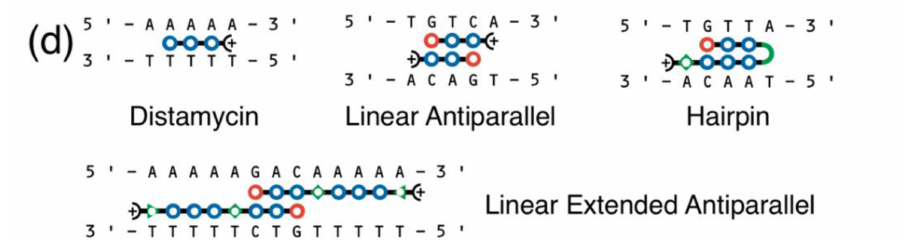
Figure 1. Schematics of pyrrole-imidazole polyamides and DNA binding. ( a ) Structure of distamycin A. ( b ) Illustrative model of hydrogen-bonding interactions between pyrrole-imidazole polyamides (PIPs) and the DNA minor groove; circles with dots represent lone pairs of purines and pyrimidines; circles containing an H represent the additional hydrogen on G; putative hydrogen bonds are indicated with dotted lines. Reprinted with permission from [1], © 2001 American Chemical Society. ( c ) Local conformation modeling of N -methylpyrroles (Py, top) and N -methylimidazoles (Im, bottom) in PIP backbones. Bond angles x-y-z and 1-y-2 are indicated directly below. Reprinted with permission from [15], © 2011 American Chemical Society. ( d ) Example of various binding models’ PIP-DNA minor-groove complexes: linear antiparallel, hairpin and linear extended antiparallel. Red and blue circles represent imidazole and pyrrole rings, respectively; green triangles, diamonds, curved green lines and + ) represent glycine, β -alanine, γ -aminobutyric acid and the N , N -dimethylaminopropylamide (Dp) capping, respectively. Reprinted from [16], © 1996, with permission from